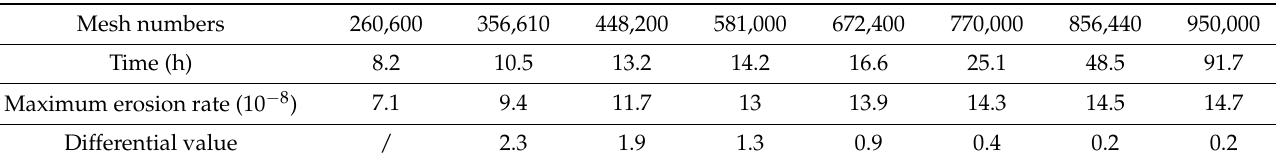
Figure 4. Maximum erosion rates for different mesh numbers at a fluid flow rate of 15 m/s. Table 3. Effect of mesh addition on time and difference variation.